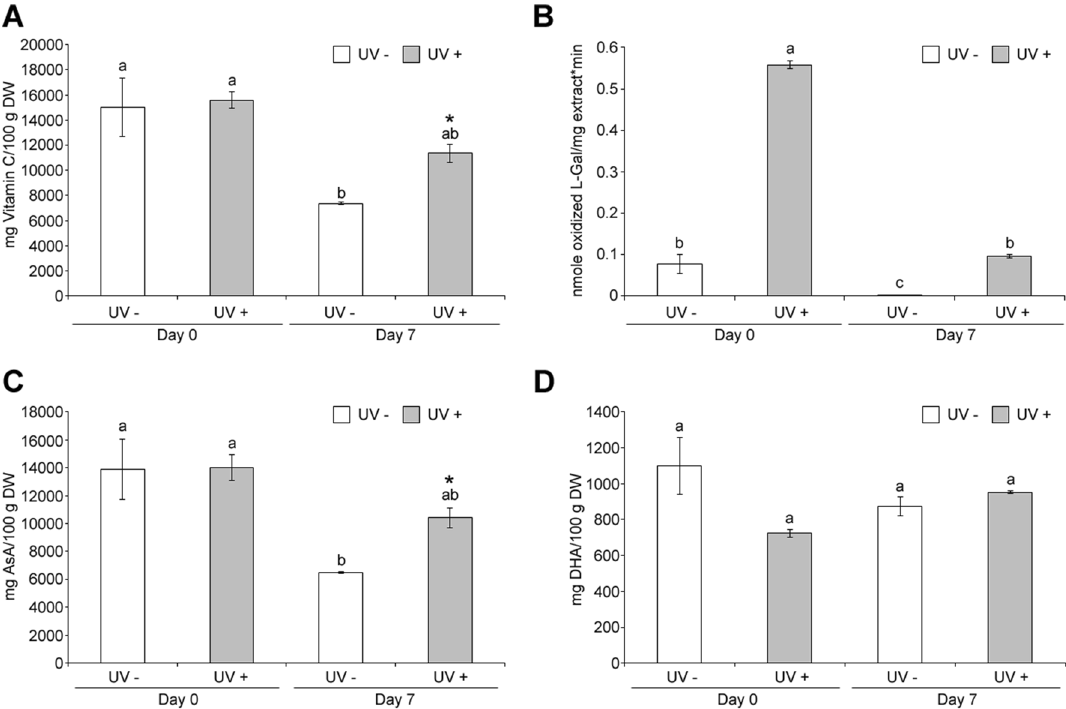
Figure 1. Effect of UVC on vitamin C metabolism. Acerola fruits without (UV−) or with UVC treatment (UV+), were stored at 10 °C for 0 day (Day 0) or 7 days (Day 7) and subjected to quantification of total vitamin C ( A ), AsA ( C ), DHA ( D ), and GalDH activity assay ( B ). Data, obtained from at least three biological repeats, are shown as mean ± SE values. Different letters indicate significant differences by the ANOVA/Tukey-HSD ( p < 0.05) while asterisks in ( A ) and ( C ) represent significant differences between UVC treated (UV−) and untreated (UV+) samples at only Day 7, using the Student’s t-test ( p < decreased in acerola fruits right after the UVC treatment by ~ 44%. However, total phenolic content decreased significantly less in UVC treated samples compared to control fruits after 7 days (Fig. 3) showing ~ 82% more phenolics than controls. These results indicate that UVC enhances the retention of phenolics in acerolas during postharvest storage. Crude extracts were separated into four fractions and liquid chromatograms revealed that UV treated and control samples showed several peaks in F3 and F4 fractions with similar chromatograms (Fig. S1). Peaks were identified by mass spectrometry in F3 as phenolic acids (peaks 1c, 1d), kaempferol derivatives (peaks 6, 10, 11), isorhamnetin and derivatives (peaks 7, 8, 9), quercetin glycosides (peak 12, 13) and myricetin derivatives (peaks 14–16) while in F4 peaks were identified as cyanidin glycosides (peaks 1e, 5), pelargonidin derivatives (peaks 2, 3) and peonidin glycoside (peak 4) (Fig. S1, Table S1). The total amount of phenolics at day 0 was ~ 1526 mg/100 g DW in control samples containing ~ 0.45, 10.9 and 88.6% phenolic acids, flavonols and anthocyanins, respectively. The most abundant flavonols were peaks 8, 11, 15, 16 and for anthocyanins, peaks 1e and 2 (Fig. S1, Table 1). Details of peak identifications are presented as supplementary information. Based on the chromatograms there was a decrease on most flavonols on day 0 after the UVC treatment compared to controls ( p < 0.05), however, at day 7 there was an increase in most peaks including most abundant peaks 8, 11 and 16 (~ 31–125%, p < 0.05) for both UVC treated samples and controls, associated likely to the normal ripening process and the additional effect of the UVC treatment while flavonol peaks 10, 12, 15 were only enhanced by UVC at day 7 (~ 67–125%, p < 0.05) (Fig. S1, Table 1). On the other hand, for anthocyanins on day 0 there was a decrease in peaks 1e and 2 (~ 61–63%, p < 0.05) and an increase in peaks 3, 4 and 5 (~ 75–458%, p < 0.05) for UVC treated samples compared to controls, while at day 7 there was a drastic decrease on all peaks for control samples but this decrease was to a lesser extent for UVC treated samples ( p < 0.05) (Fig. S1, Table 1). For phenolic acids peaks 1c and 1d, changes were less evident with only coumaroyl quinic acid showing a larger increase at day 7 for UV treated fruits compared to controls (~ 52%). Accordingly, UVC led to the biosynthesis of polyphenols and induced changes in phenolic profiles in acerola. UVC effect on phenylalanine ammonia‑lyase (PAL) and polyphenol oxidase (PPO) enzymatic activities. UVC induced an increase in PAL activity compared to controls at day 0 (Fig. 4a) and this increase in PAL activity due to UVC was larger at day 7 (Fig. 4a), confirming UVC induced biosynthesis of polyphenols in acerola. The effect of UVC on PPO activity was also investigated (Fig. 4b). PPO activity increased significantly only after 7 days of UVC irradiation, when compared to control. This suggests that the increase in PPO activity observed during storage of UVC treated samples enhanced phenolic conversion into o -quinones, which eventu-